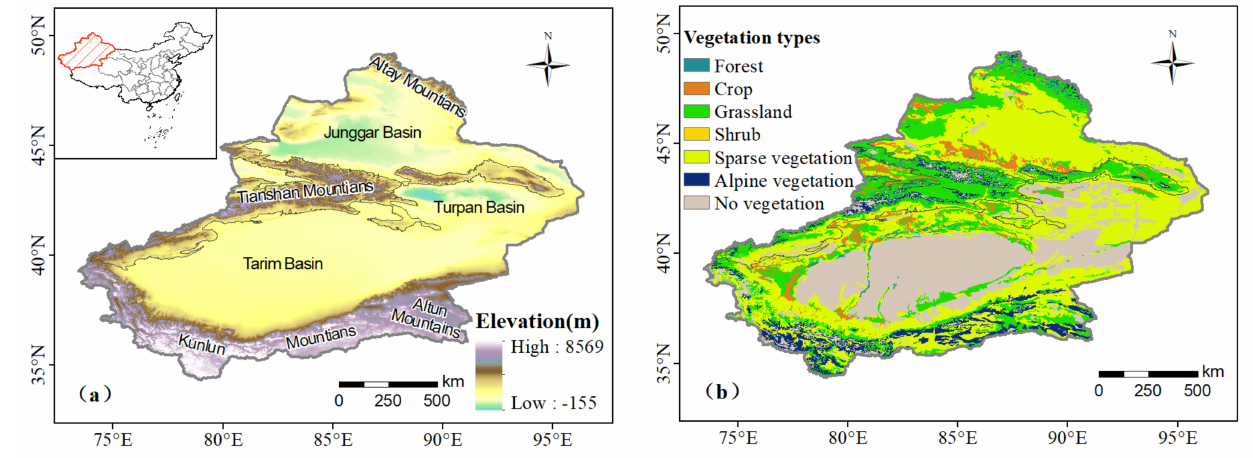
Figure 1. Study area. ( a ) Elevation; ( b ) vegetation types.